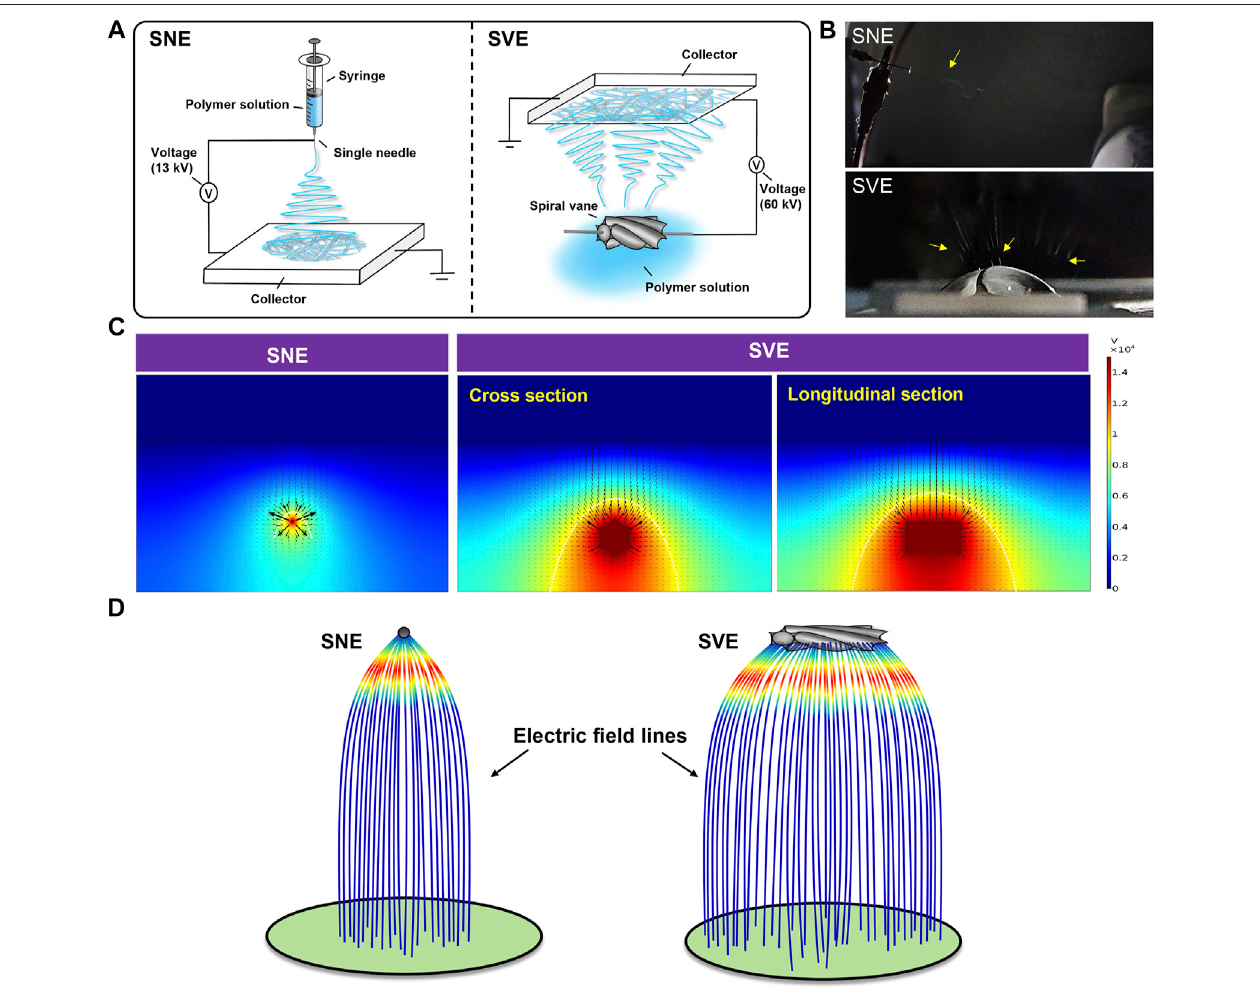
FIGURE 1 | Mechanism analysis of SNE and SVE processes: (A) schematic diagrams; (B) pictures of electrospinning processes. The yellow arrows represent the generated jets. (C) Electric fi eld distributions of single-needle and spiral-vane systems; (D) simulative electric fi eld lines produced by the single-needle and spiral-vane